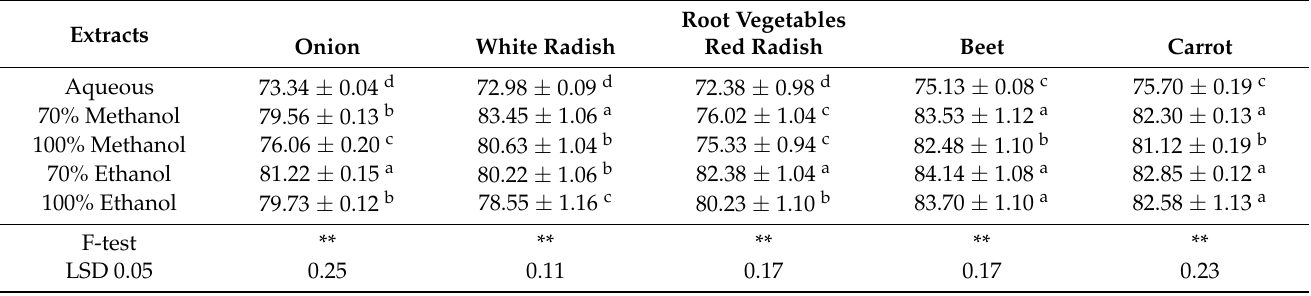
Table 3. The hydrogen peroxide scavenging activity (%) of the aerial part of selected root vegetables. Root Vegetables